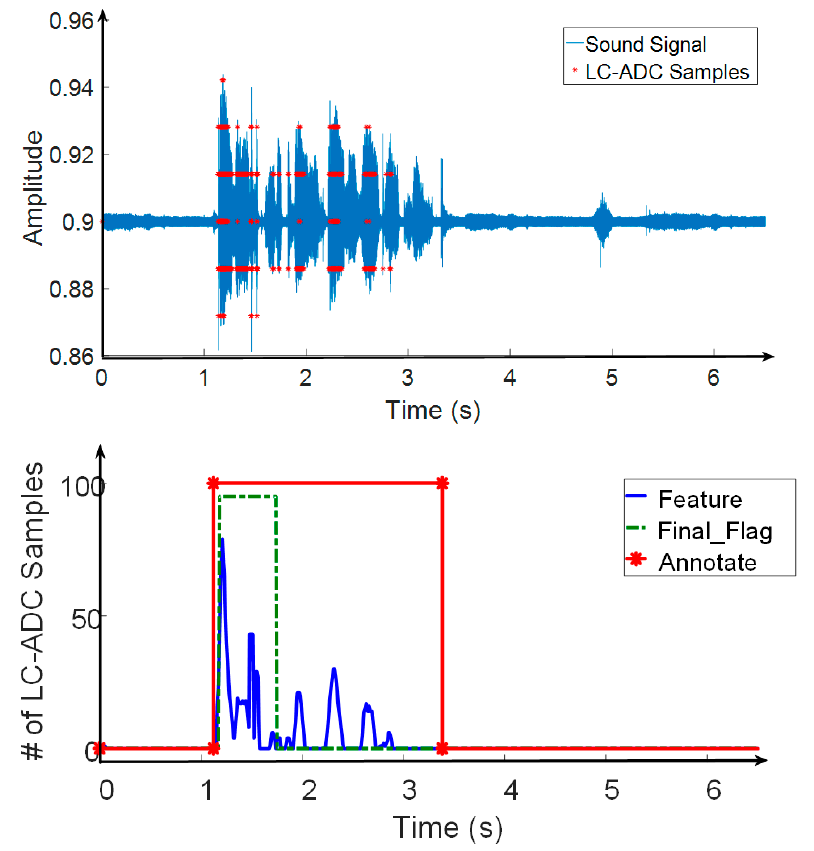
Figure 13. Missing speech detection due to low signal amplitude and lack of enough samples.